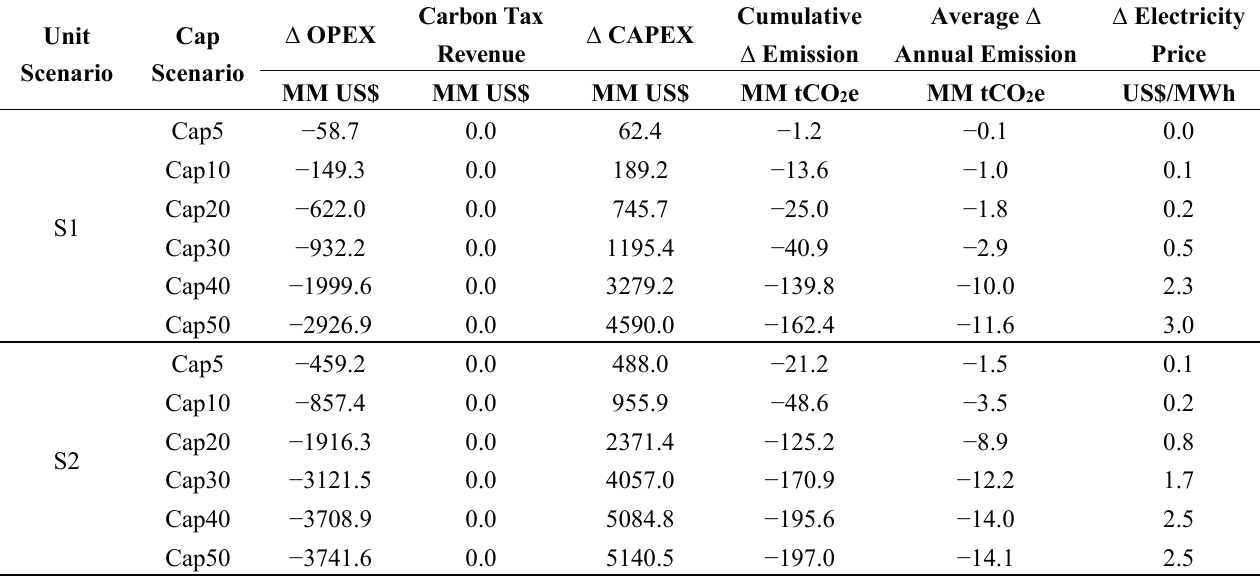
Table 7. Indicators associated to the application of sectorial cap on the Chilean electricity generation sector in the four scenarios (MM =